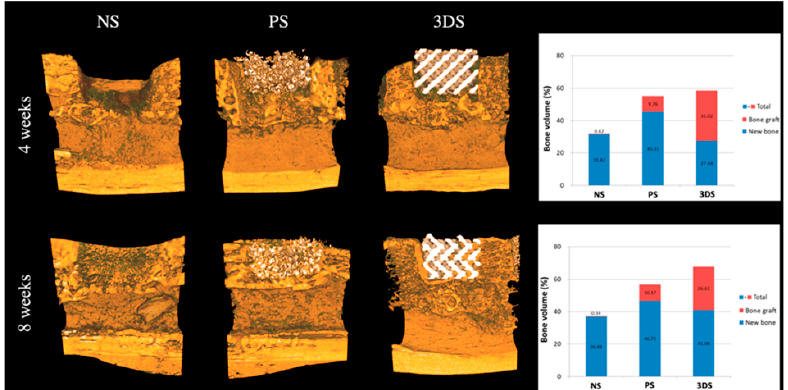
Figure 3. Radiological evaluation at 4 and 8 weeks. The 3DS and PS groups showed greater values of the total amount of bone than the NS group at 4 weeks. There were no significant differences in the amounts of new bone at 8 weeks among all the groups. The three groups from the highest to least relative total amounts of bone were: 3DS, PS and NS. 3DS: 3D-printed HA/TCP; PS: Particle-type substitute (OSTEON 3, Genoss ® , Suwon, Korea); NS: Untreated defect [43].